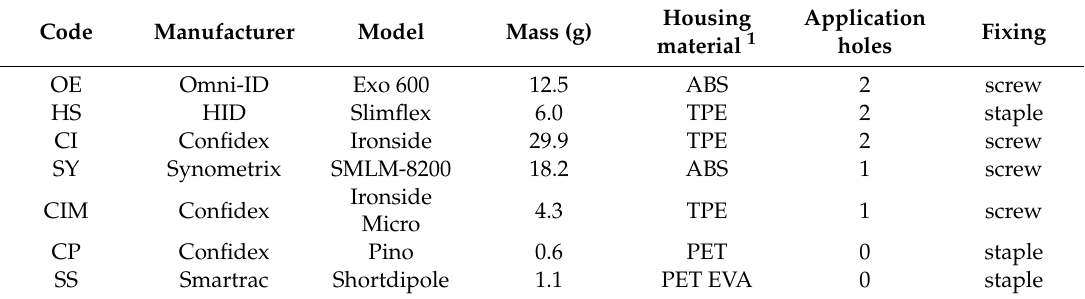
Table 1. Technical characteristics of radio frequency identification (RFID) ultra-high-frequency (UHF) tag models used for the